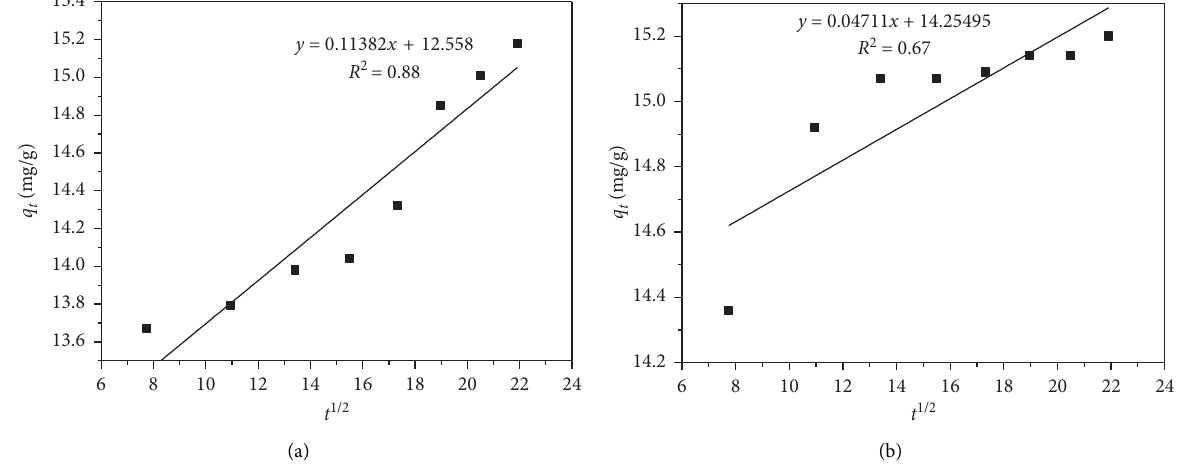
Figure 9: Plots of the intraparticle kinetics of MB dye adsorption on the geopolymer (a) without UV and (b) with UV. Table 3: Parameters of kinetics models for the adsorption of MB on the geopolymer. Pseudo-first-order Pseudo-second-order Intraparticle diffusion Condition q ex (mg/g) Without